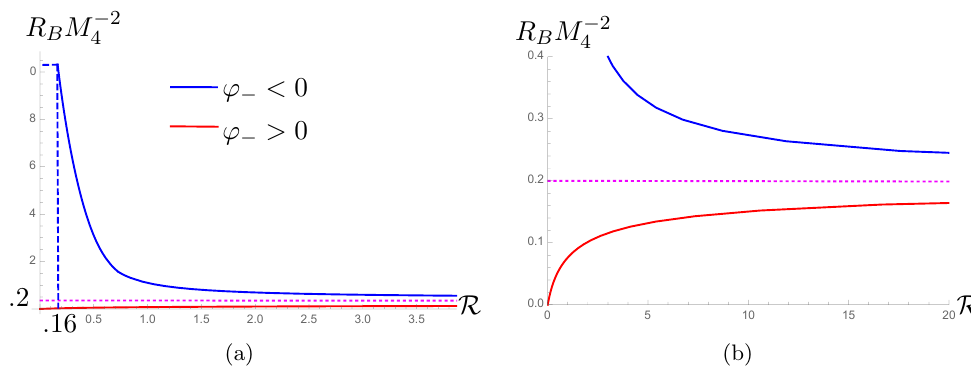
Figure 8 . Brane curvature in units of the 4d Planck mass R B M (cid:0) 2 brane quantities (3.2) and parameter values (3.3). In (cid:12)gure (a) both solutions with ’ (cid:0) < 0 and ’ (cid:0) > 0 are shown. In (cid:12)gure (b) we adjusted the plot range to improve visibility of the result with ’ (cid:0) > 0. For R ! 1 both the red and blue branch asymptote to the value for R B M (cid:0) 2 by the dotted magenta